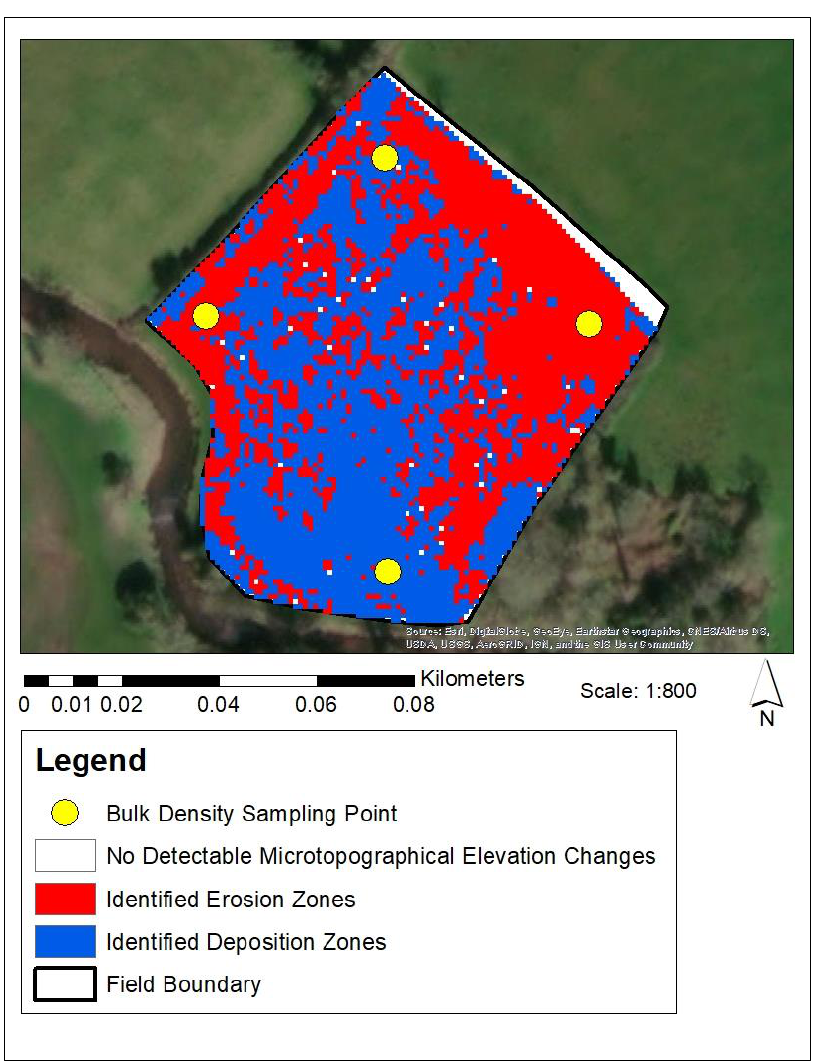
Figure 4. Identified erosion and deposition zones and areas of no detectable microtopographical elevation changes. Bulk density sampling point locations are marked. Table 4. Volume change rates, deposition and erosion rates, and sediment mass wasting rates re- lated to soil erosion induced by tillage and reseeding.